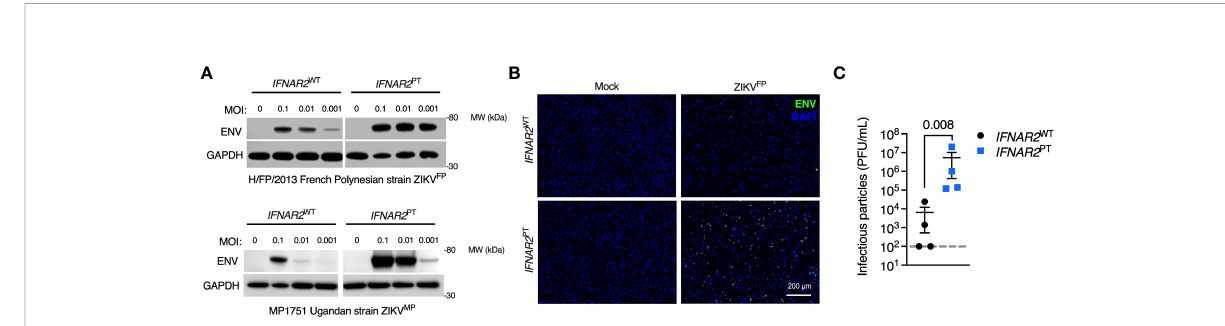
FIGURE 3 Enhanced ZIKV replication in IFNAR2 de fi cient iPS-macrophages. (A) Immunoblot of ENV and GAPDH expression in IFNAR2 WT (WT2) and IFNAR2 PT (clone 11) iPS-M f , 72 h.p.i. with Asian lineage (ZIKV FP ) and African lineage (ZIKV MP ) at the MOI demonstrated, representative of n = 3 independent experiments. (B) Immuno fl uorescence analysis of ENV expression in IFNAR2 WT (WT2) and IFNAR2 PT (clone 11) iPS-M f (24 h.p.i. with ZIKV FP MOI=1.0), representative of n = 3 independent experiments. (C) Plaque assay on Vero cells of ZIKV infectious particles in supernatants (48 h.p.i. ZIKV FP MOI = 0.001, n = 4 independent experiments in IFNAR2 WT [clones WT1 & WT2] and IFNAR2 PT [clones 6 & 11]). Mean ± SD, t test.